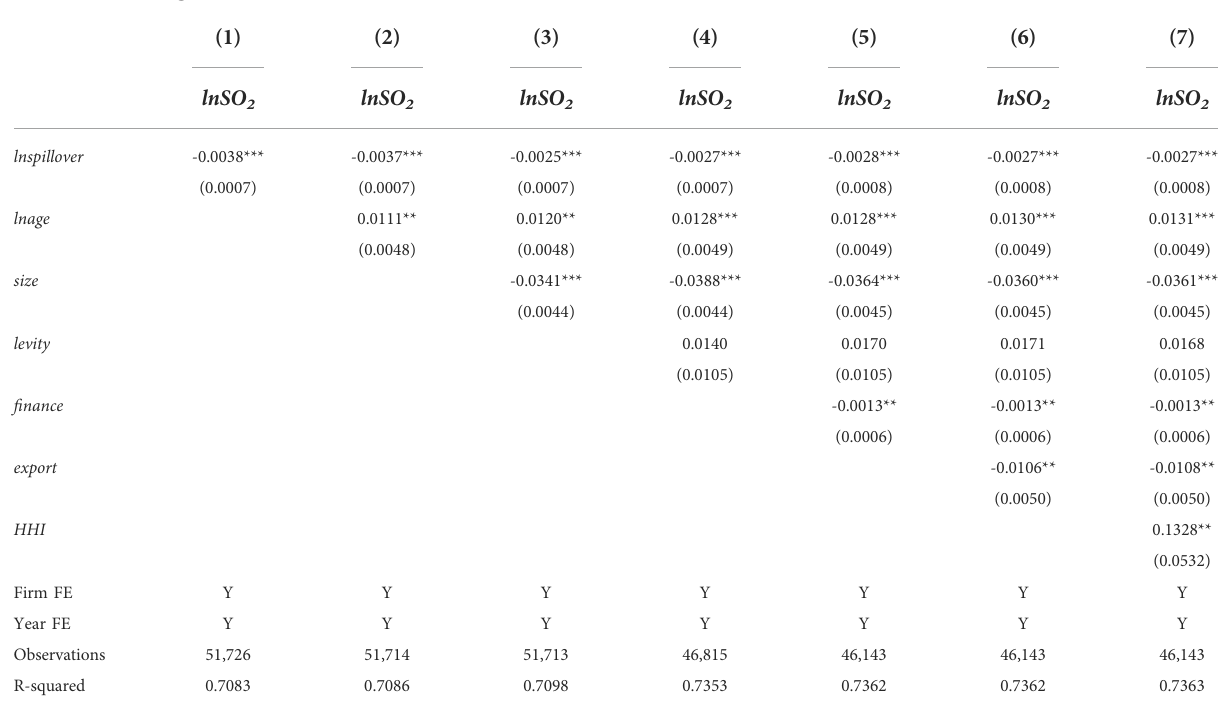
TABLE 2 Baseline